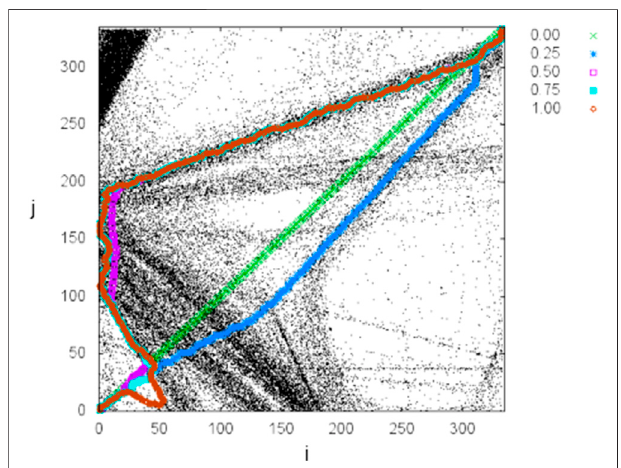
FIGURE 3 | Optimal paths between the lower left and upper right corner of the grid in Figure 1B for α (cid:3) 0, 0.25, 0.50, 0.75 and 1. The parameter β , de fi ned in Eq. 15 was set to zero.